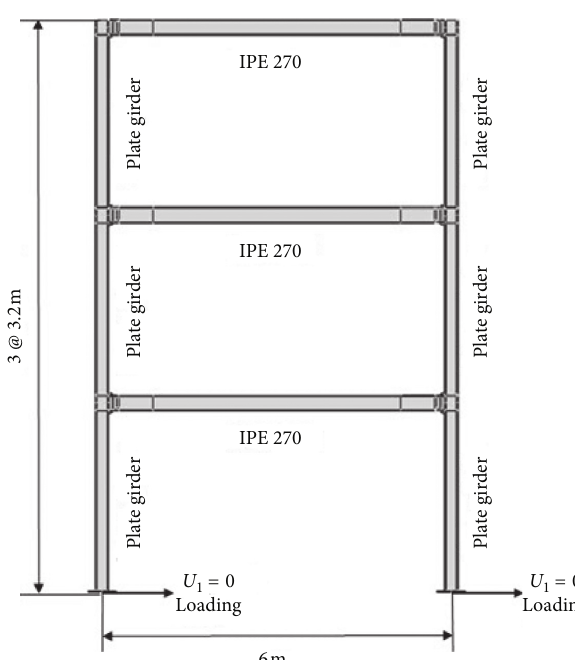
Figure 10: Three-story modelled